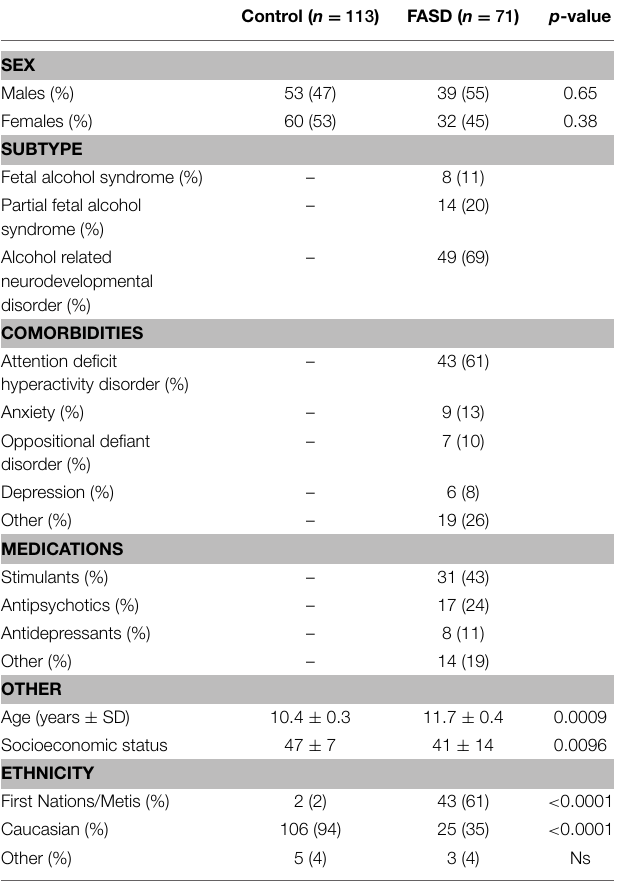
TABLE 1 | Demographic variables for control and FASD